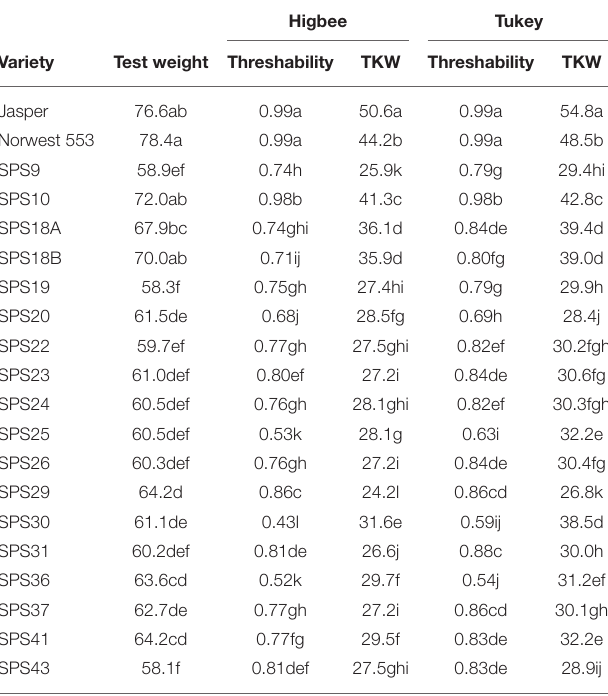
TABLE 8 | Mean test weight (kg/hL) of harvested grain of different varieties. Higbee